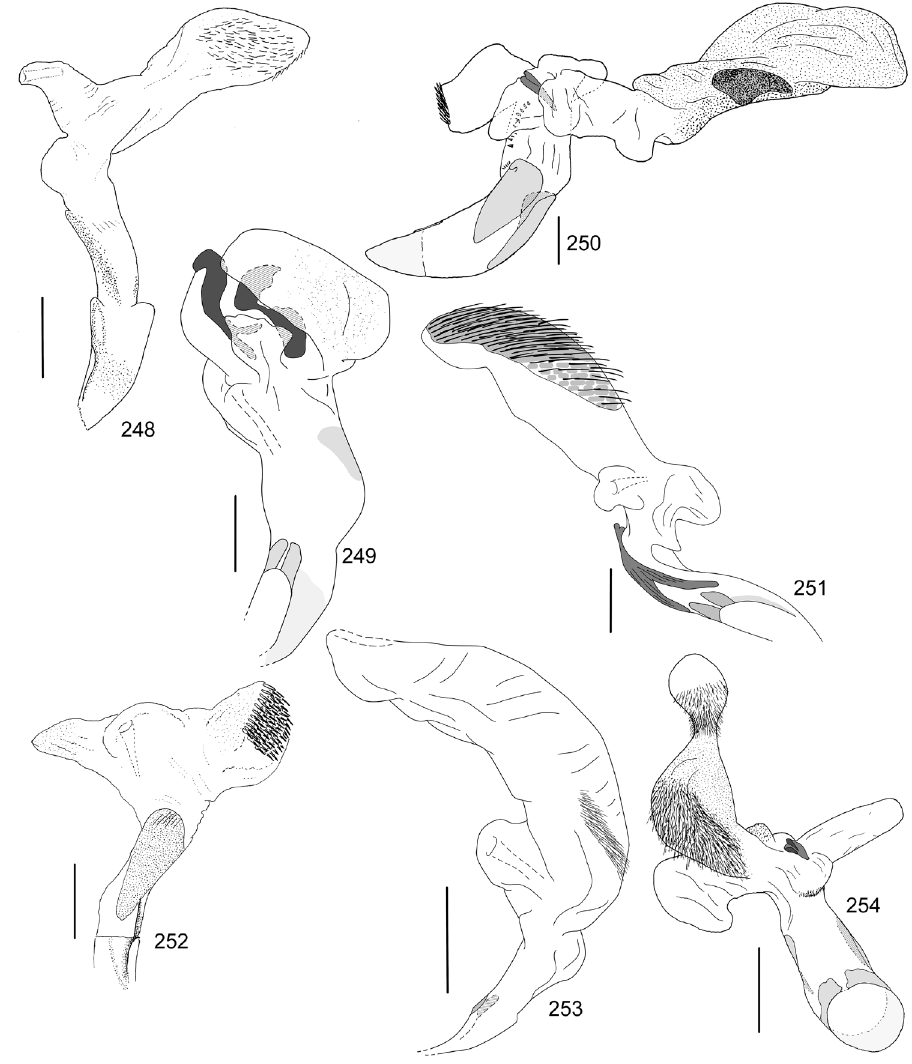
Figures 248–254. Endophallus of 248 Anomala eucoma (San José, San José, MUCR) 249 A. eulissa (Sector Cedrales de la Rita, Limón, MNCR) 250 A. eusticta (Estación La Casona, Puntarenas, MNCR) 251 A. ferrea (Las Cruces, Puntarenas, MNCR) 252 A. flavacoma (Estación Cabro Muco, Guanacaste, CEUA) 253 A. foraminosa (Estación Hitoy Cerere, Limón, MNCR) 254 A. globulata (reconstructed from two specimens: Macizo de la Muerte and Reserva forestal Río Macho, Cartago, MNCR). Scale bars: 1 mm. Figs 248, 252 from Filippini et al. (2013); Fig. 251 from Filippini et al. (2014); Figs 250, 254 from Filippini et al.